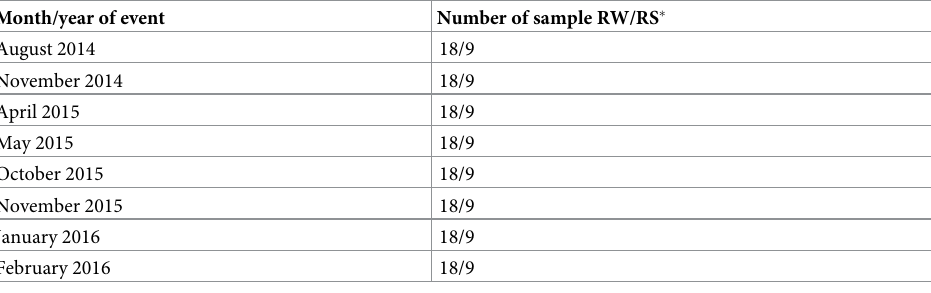
Table 1. Number of samples collected during mass-bathing events took place in river Kshipra, Central India dur- ing study period. Month/year of